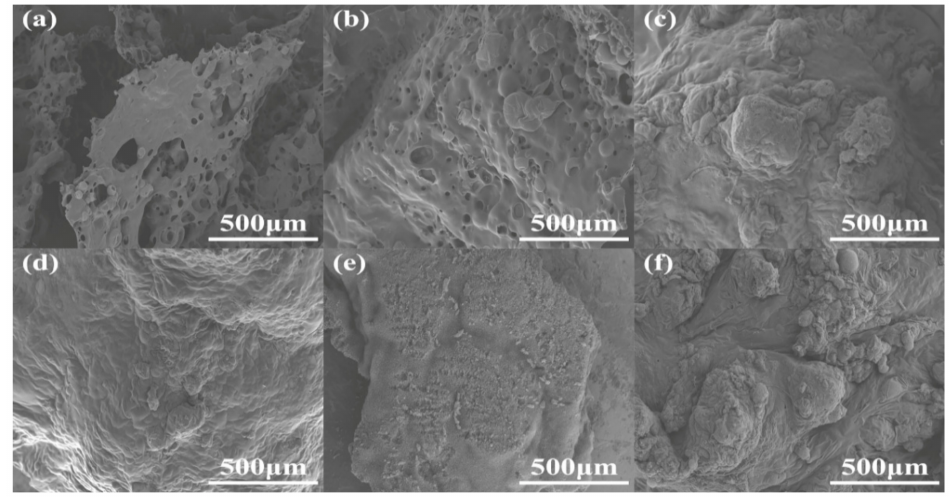
Figure 8. SEM images of char residues of neat RPUF ( a ), RPUF–T15 to RPUF–T45@SA20 ( b – f